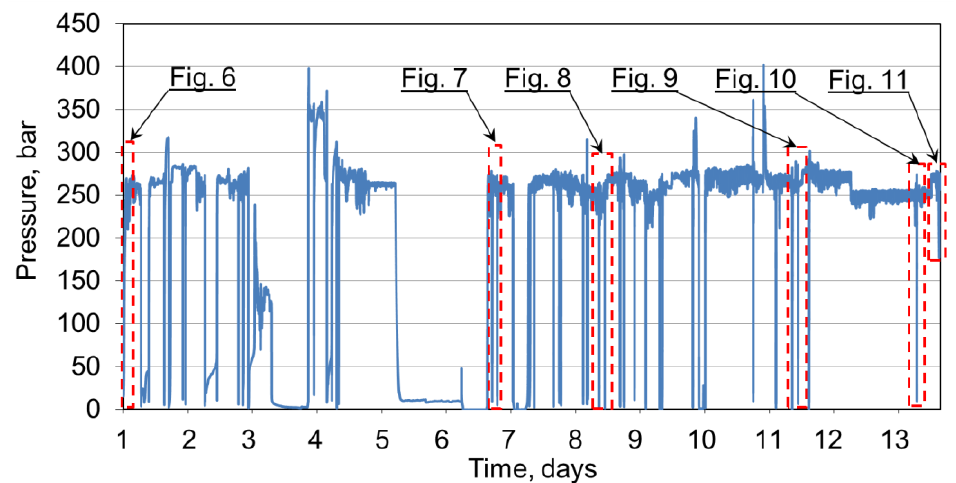
Figure 5. Testing the functionality of a double block in real conditions.